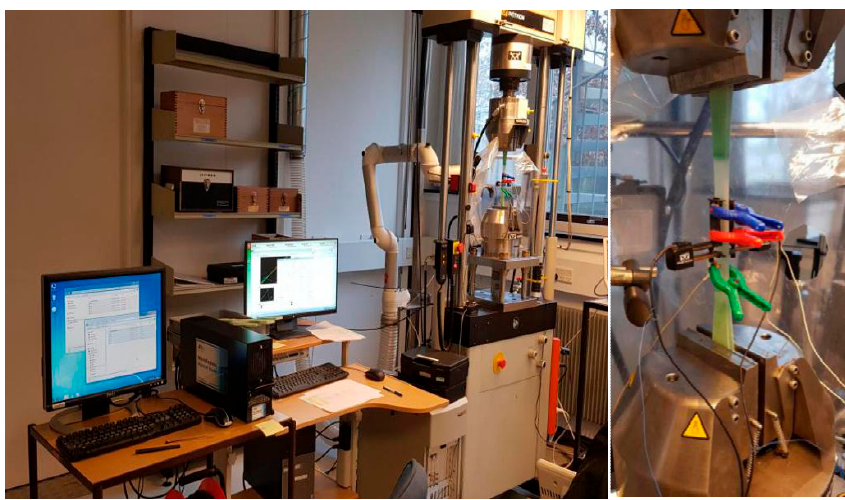
Figure 11. Tensile fatigue test set up showing (from left to right ) AE system, control system, and test rig, and a close up of the test specimen prior to loading, with extensometor and AE sensor clamped in place.